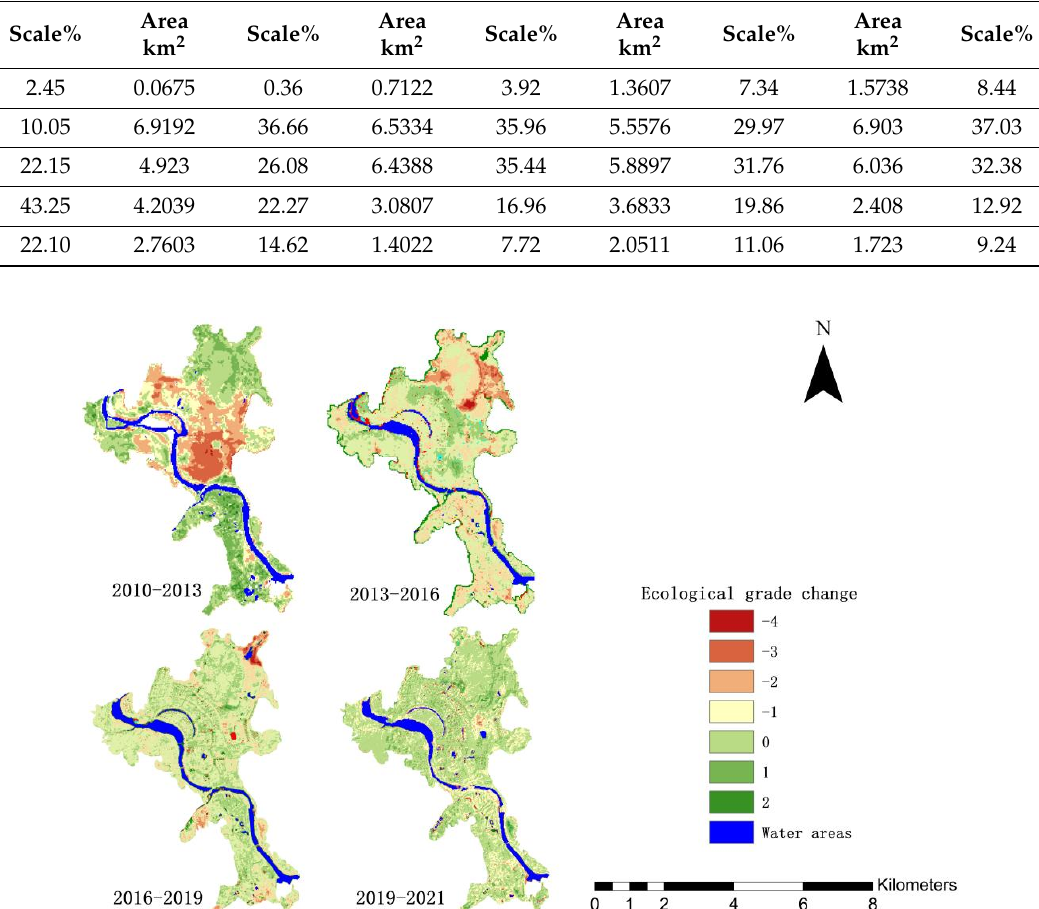
Figure 10. Ecological grade change map.